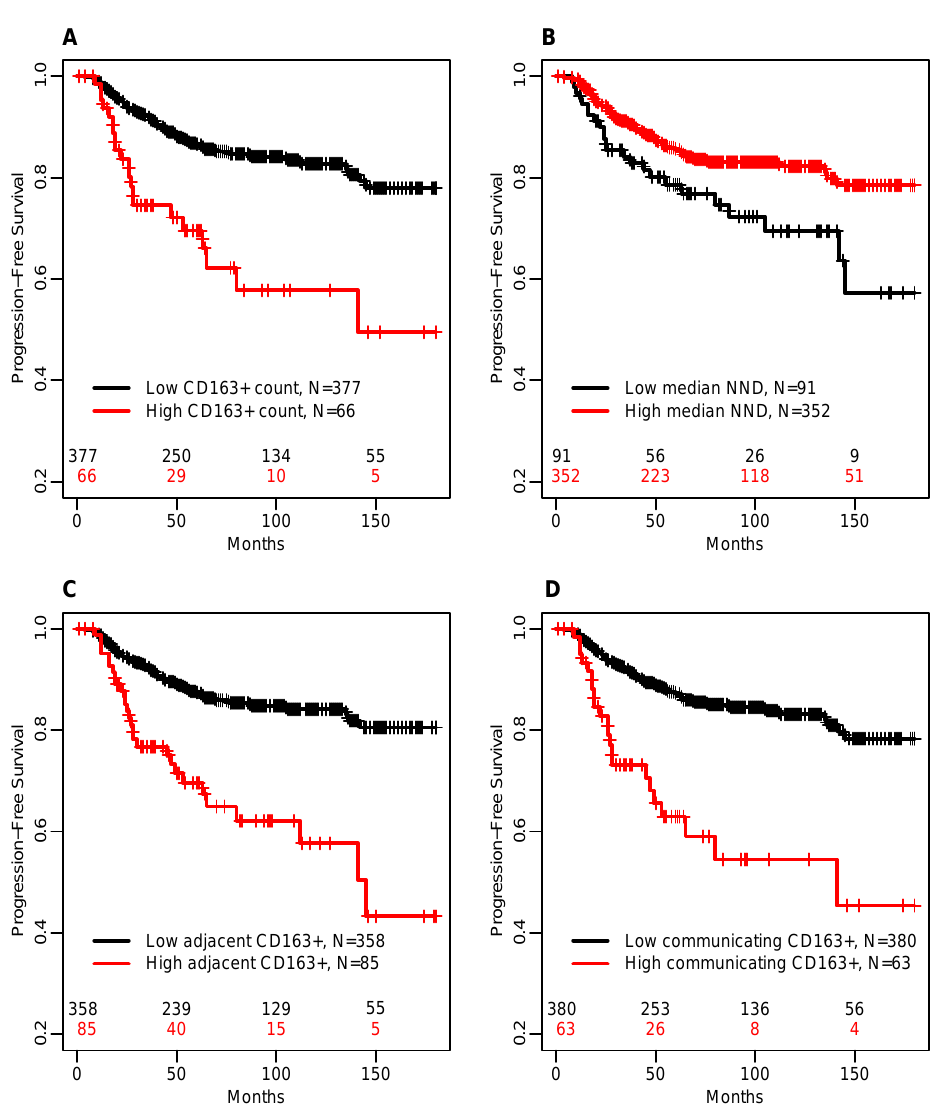
Figure 3. Kaplan–Meier plots of PFS by CD163-related markers with the highest prognostic value in the multivariable Cox model adjusted for significant clinicopathologic risk factors. ( A ) total number of CD163 + TAMs in the sampled tumor area (CD163 + Count); ( B ) median nearest neighbor distance (median NND) from cancer cells to CD163 + TAMs; ( C ) the average number of CD163 + TAMs within 12 µ m distance of each cancer cell (adjacent CD163 + ); ( D ) the average number of CD163 + TAMs within 250 µ m distance of each cancer cell (communicating CD163 +